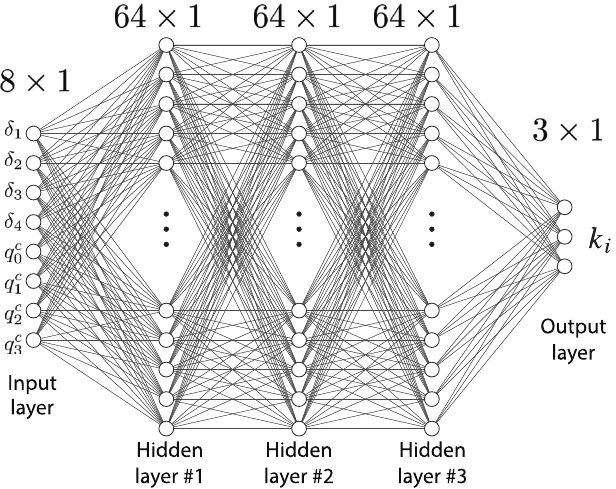
Figure 5. Visualization of the DNN model.